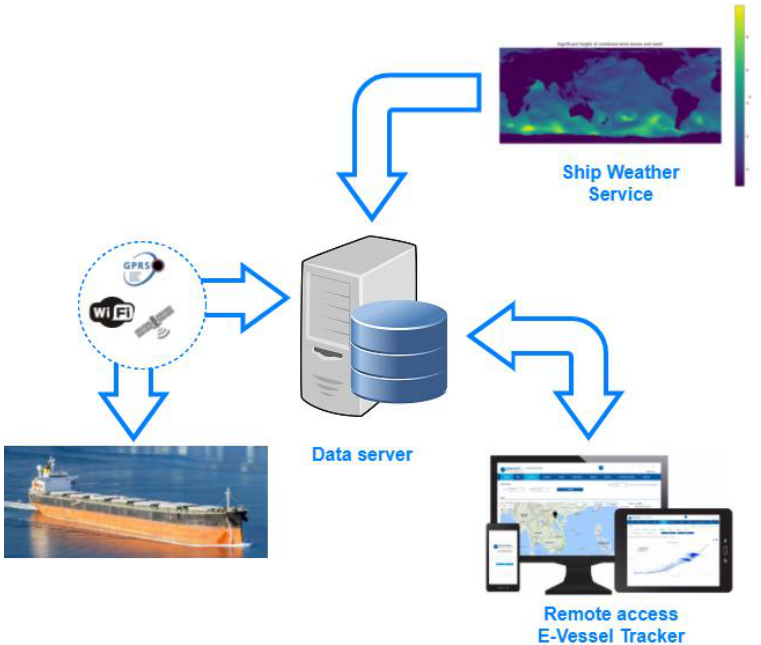
Figure 2. Scheme of ship to shore data transfer and online access to data with the use of web application.